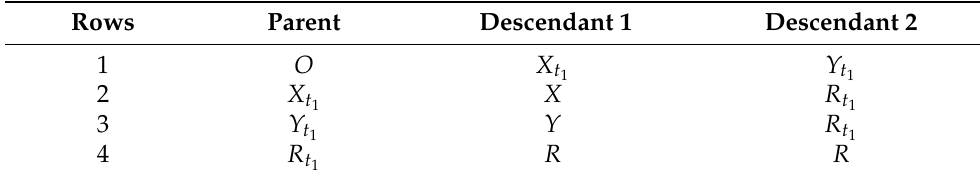
Table 1. Ancestral–descendant relationship corresponding to Figure 1.